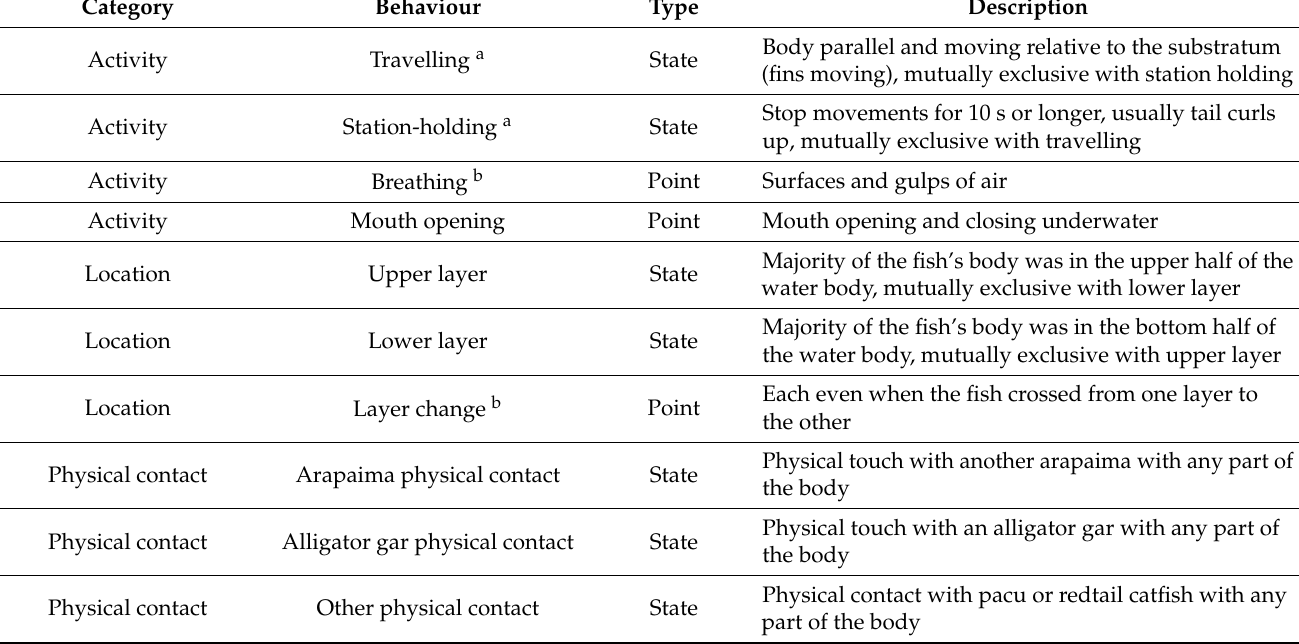
Table 2. Operational definition of the observed behavioural factors, behaviours were defined as State events (with duration) or Point events (no